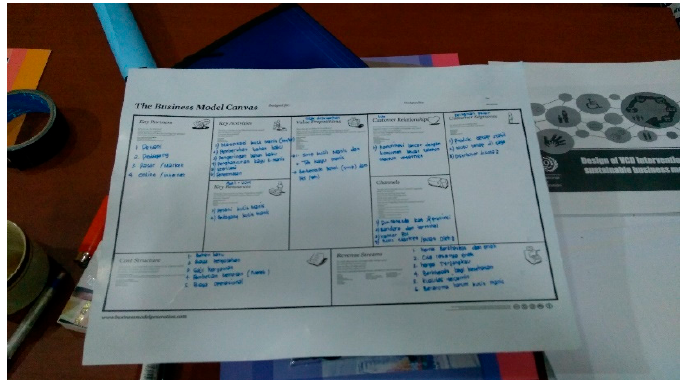
Figure 6. Business Model Canvas for GI Koerintji cinnamon .